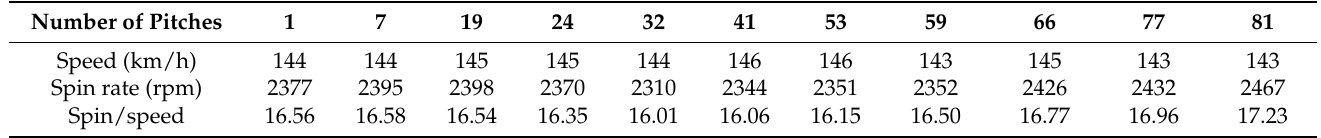
Table 6. Pitching state analysis of four-seam fastballs by Clayton